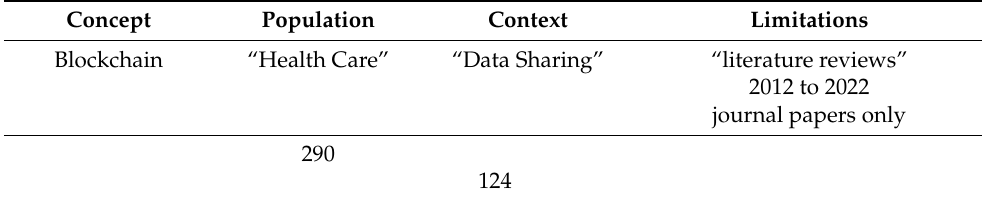
Table 1. Literature process